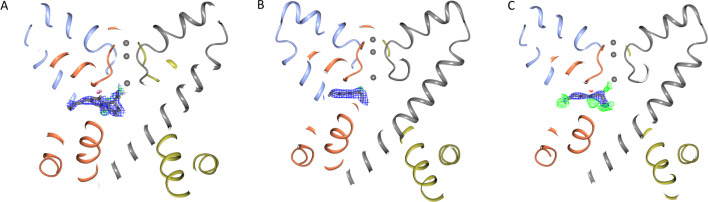
Comparisons of the electron density map of CBD in the NavMs-CBD complex with the electron density maps of Apo-NavMs crystals.(A) CBD molecule fit into the NavMs-CBD crystal structure (overlaid by the 2Fo-Fc map contoured at 0.75 sigma), indicating the fit of the CBD to the density. (B) Aliphatic (C9H20) part of a lipid (or detergent) molecule (overlaid by the (2Fo-Fc) density (also contoured in blue at 0.75 sigma) in the crystal structure of Apo-NavMs. (C) The C9H20 structure refined into the NavMs-CBD (2Fo-Fc) (blue) map also contoured at 0.75 sigma [but without CBD structure present during refinement]. The green and red meshes (Fo-Fc maps contoured at sigma = 3) correspond to unaccounted for positive and negative densities, respectively). This clearly indicates that the density seen in the NavMs-CBD map is not due to bound lipid or detergent. The extra densities seen in the apo-NavMs maps may, however, arise from transient/partial occupancy of the cavity by a lipid, as had been indicated by molecular dynamics simulations (Ulmschneider et al., 2013), but occupancy by a lipid molecule for any significant time period is unlikely as it would inhibit the entry of hydrophobic drugs into the fenestration. In all panels the protein is shown in ribbon depiction (different colours for different polypeptide chains in the tetramer) and the three sodium ions present in the channel selectivity filter are shown as small grey balls, for visual reference.